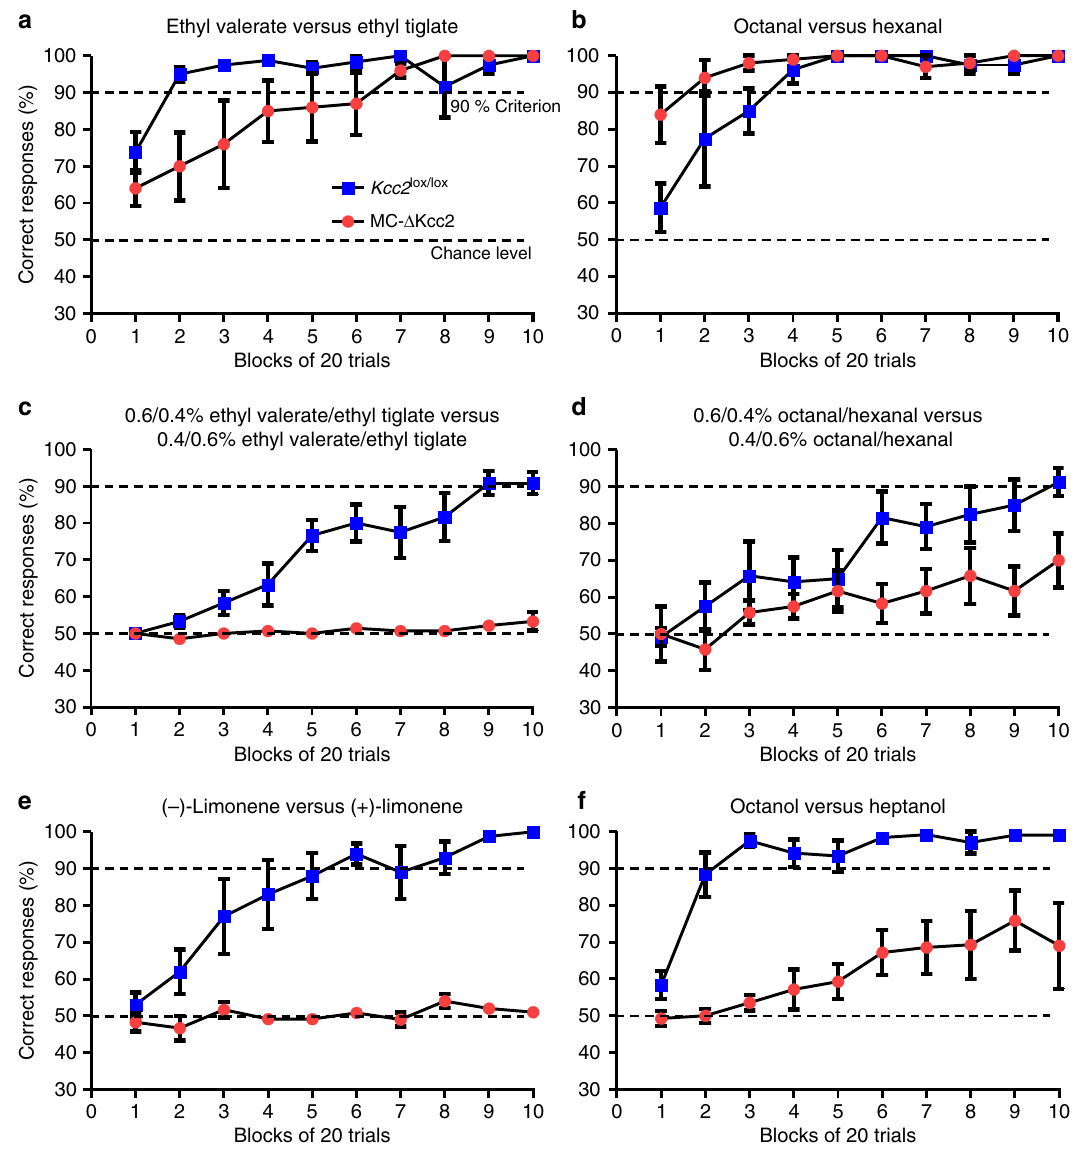
Figure 7 | Impact of Kcc2 disruption on odour discrimination. ( a , b ) MC- D Kcc2 ( n ¼ 4 mice) and Kcc2 lox/lox ( n ¼ 5 mice) mice were able to discriminate between two structurally distinct odours, 1% ethyl valerate versus 1% ethyl tiglate ( a ) and 1% octanal versus 1% hexanal ( b ). Mice of both genotypes learned to discriminate these odours with an accuracy of more than 90% correct answers. ( c , d ) MC- D Kcc2 mice show deficits in the ability to discriminate between mixtures of the odours tested in a and b . The following combinations were tested: 0.6/0.4 ethyl valerate/ethyl tiglate versus 0.4/0.6 ethyl valerate/ethyl tiglate ( n ¼ 6 Kcc2 lox/lox against 7 MC- D Kcc2 mice); 0.6/0.4 octanal/hexanal versus 0.4/0.6 octanal/hexanal. For both tasks MC- D Kcc2 mice were not able to reach the 90% criterion in 10 tested blocks of 20 trials. ( e ) MC- D Kcc2 mice show deficits in the ability to discriminate structurally similar odours. Mice were tested to discriminate enantiomers ( (cid:2) ) limonene versus ( þ ) limonene (1%). MC- D Kcc2 ( n ¼ 6 mice) were not able to perform better than chance level, while Kcc2 lox/lox mice ( n ¼ 5 mice) reached 90% criterion after 6 blocks of 20 trials. ( f ) Mice tested to discriminate 1% octanol versus 1% heptanol. MC- D Kcc2 mice ( n ¼ 7) were not able to reach the 90% criterion in contrast to Kcc2 lox/lox mice ( n ¼ 6 mice). Data are plotted as mean ±